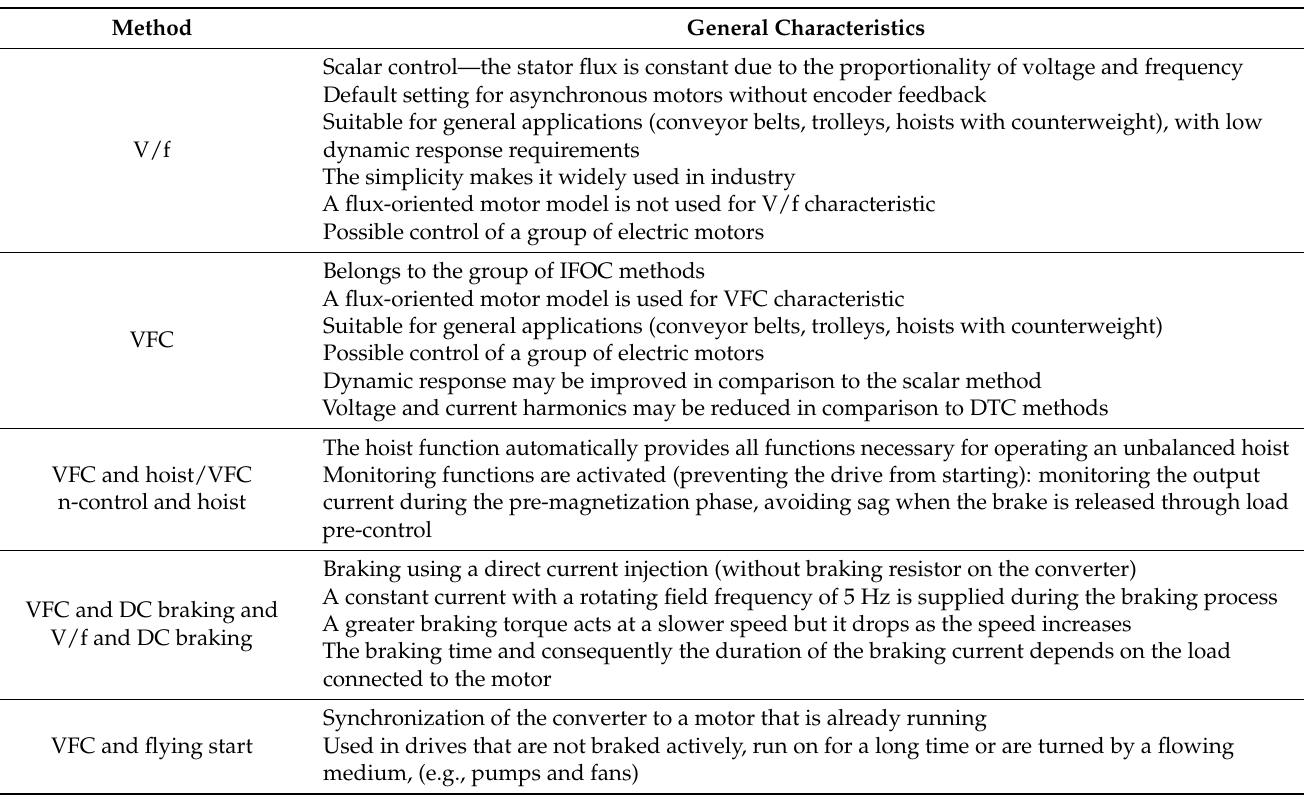
Table 1. Comparison of motor control modes